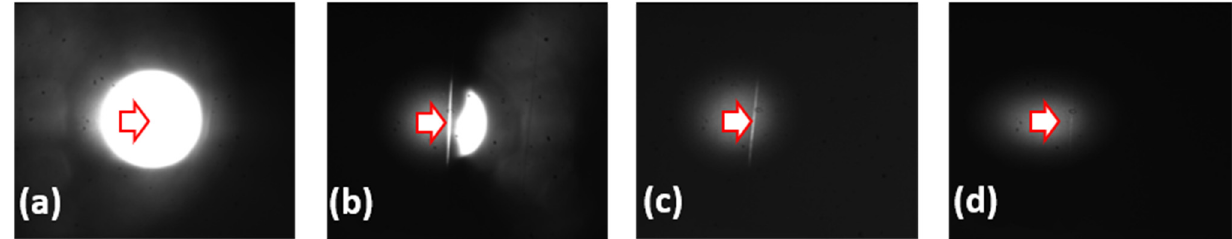
Figure 3. The scratch with scattering produced by the gray paint was observed by the camera. We rotated the transparent plate to find the best observation angle. It shows the normal direction of the sample was tilted ( a ) 0°, ( b ) 2°, ( c ) 7°, and ( d ) 13° from the incident angle.